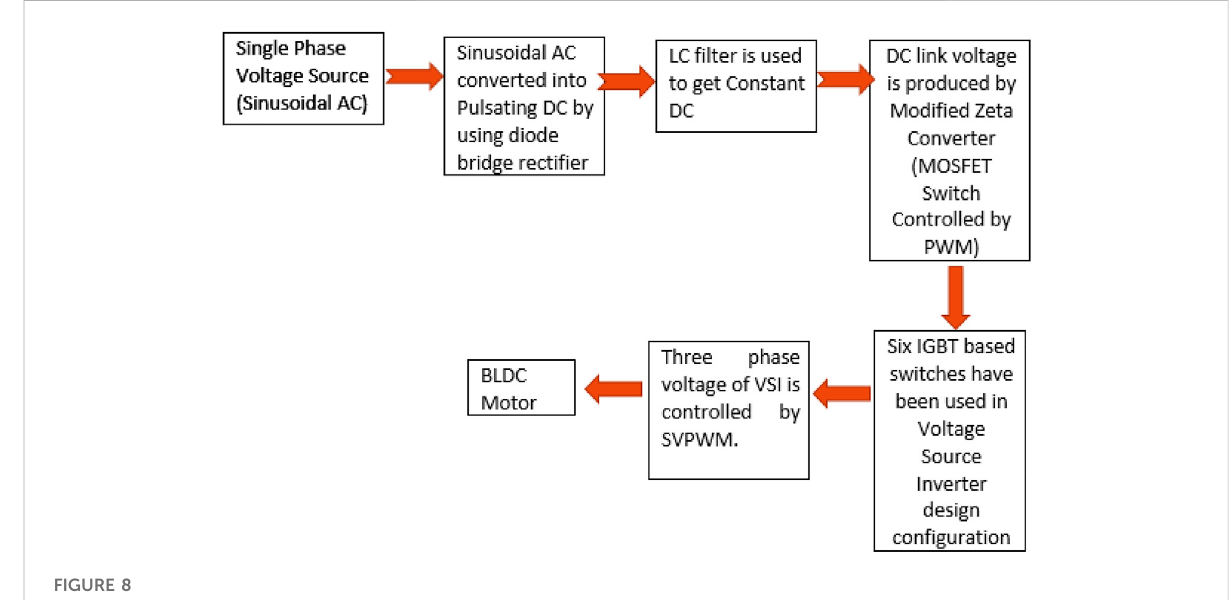
FIGURE 8 Block diagram of proposed model.